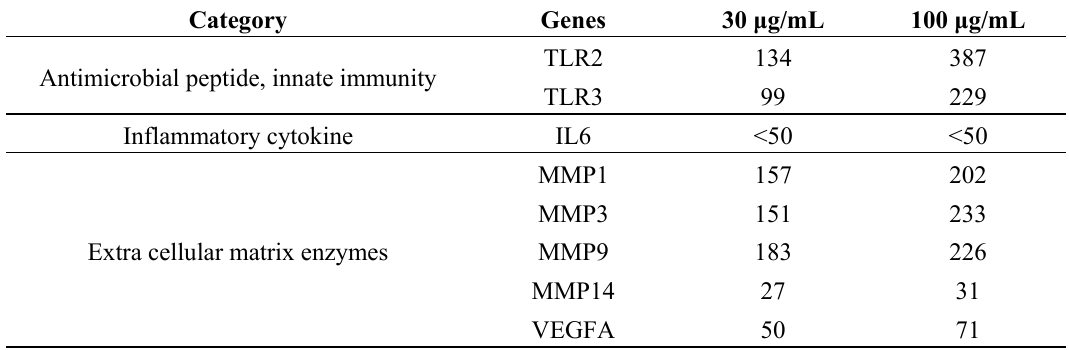
Table 7. QPA-INFLAM-TiSSUE-64 model. Summary of Undaria pinnatifida extract on gene expression profile of UVB and UVA irradiated reconstructed human